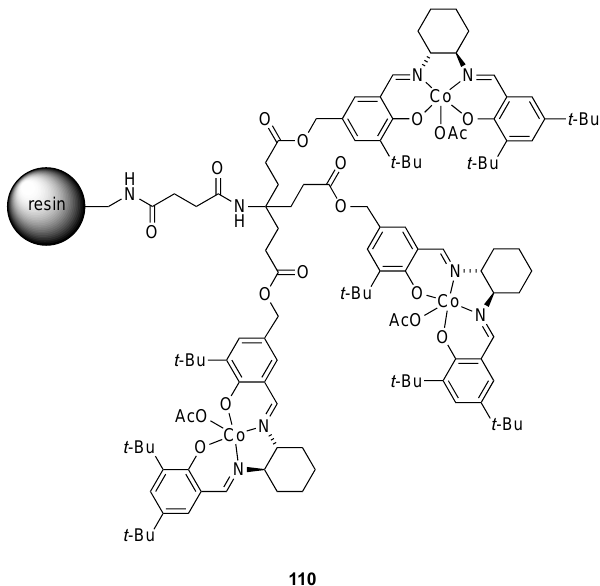
Figure 42. Resin-supported dendronized Co–salen catalyst 110 .